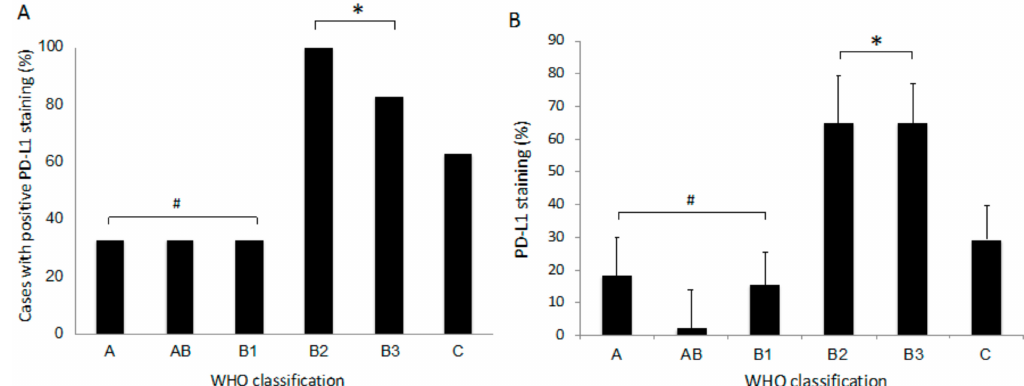
Figure 4. Comparison of PD-L1 immunohistochemical staining according to the World Health Organization (WHO) classification of TET. ( A ) Cases with positive PD-L1 staining. ( B ) PD-L1 staining score. * p < 0.05 compared to lower grades (#).